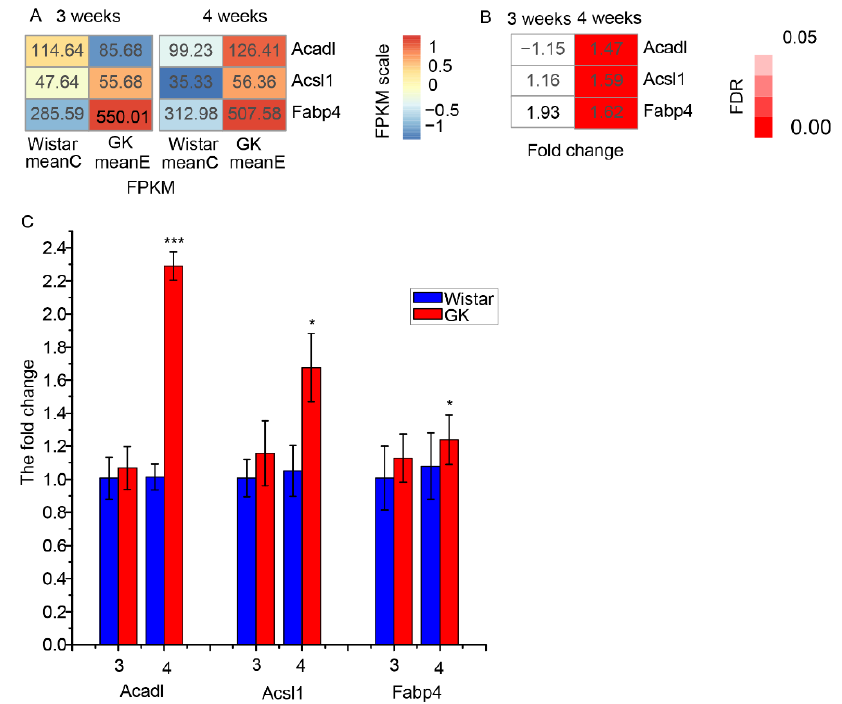
Figure 4. The differentially expressed genes related to fatty acid oxidation. ( A ) The mean FPKM of Acadl , Acsl1 and Fabp4 in skeletal muscle of GK and Wistar rats. ( B ) The fold change (meanE /meanC) and corresponding FDR values of Acadl , Acsl1 and Fabp4 in GK rats in comparison with those of Wistar rats. ( C ) The fold change (2 −ΔΔCt ) of GK genes Acadl , Acsl1 and Fabp4 expression compared with Wistar rats by RT-qPCR (data are shown as mean ± SEM. n = 6, * P < 0.05, *** P < 0.001). MeanC represents the mean FPKM of Wistar rats, while meanE represents the mean FPKM of GK rats.